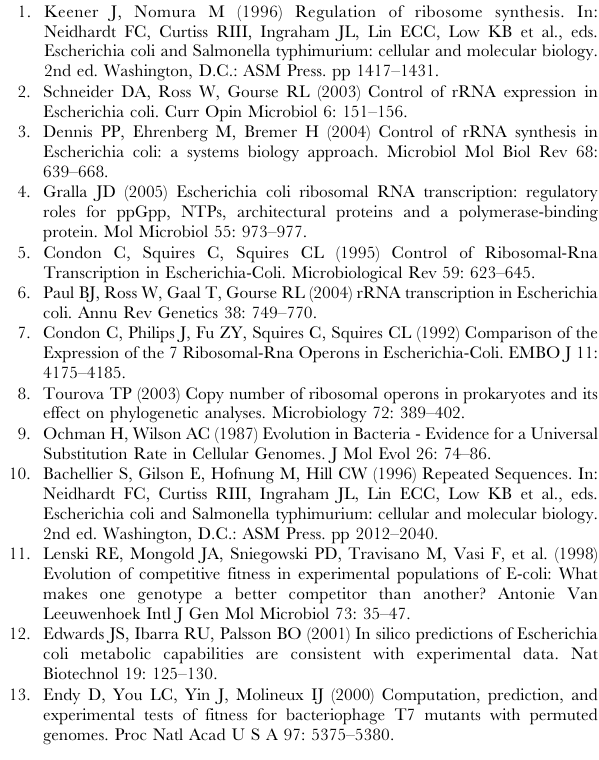
rrn gene class and bulk gene class. C and D periods were interpolated based on data from table 2 of [17] as a second order polynomial in m 2 1 . For this simulation we assumed that 66 evenly distributed bulk genes are expressed (c.f. map locations in Table S1). The initiation volume, V ini , was assumed to be fixed [41,43,100]. See also main text and S2.2 in Text S1 for further explanations. Found at: doi:10.1371/journal.pcbi.1000038.s015 (0.48 MB TIF) Figure S8 Dependence of binding affinities on the volume fraction W for the various crowding scenarios. (A) Normalized inverse equilibrium constants, K m 2 1 and L m 2 1 (in units of 1/M), for the RNAp holoenzyme (radius 5.57 nm) and the 30S ribosome subunit (radius 6.92 nm), respectively, in the transition state limited model. The water molecule radius was taken to be 0.138 nm [101] and the radius of the background crowding agent was taken to be 3.06 nm [46]. (B) Normalized K m 2 1 and L m 2 1 for the diffusion limited model (curves overlap). All curves were normalized to values at the WT volume fraction of W = 0.34. See S2.4 in Text S1 for more details. Found at: doi:10.1371/journal.pcbi.1000038.s016 (0.46 MB